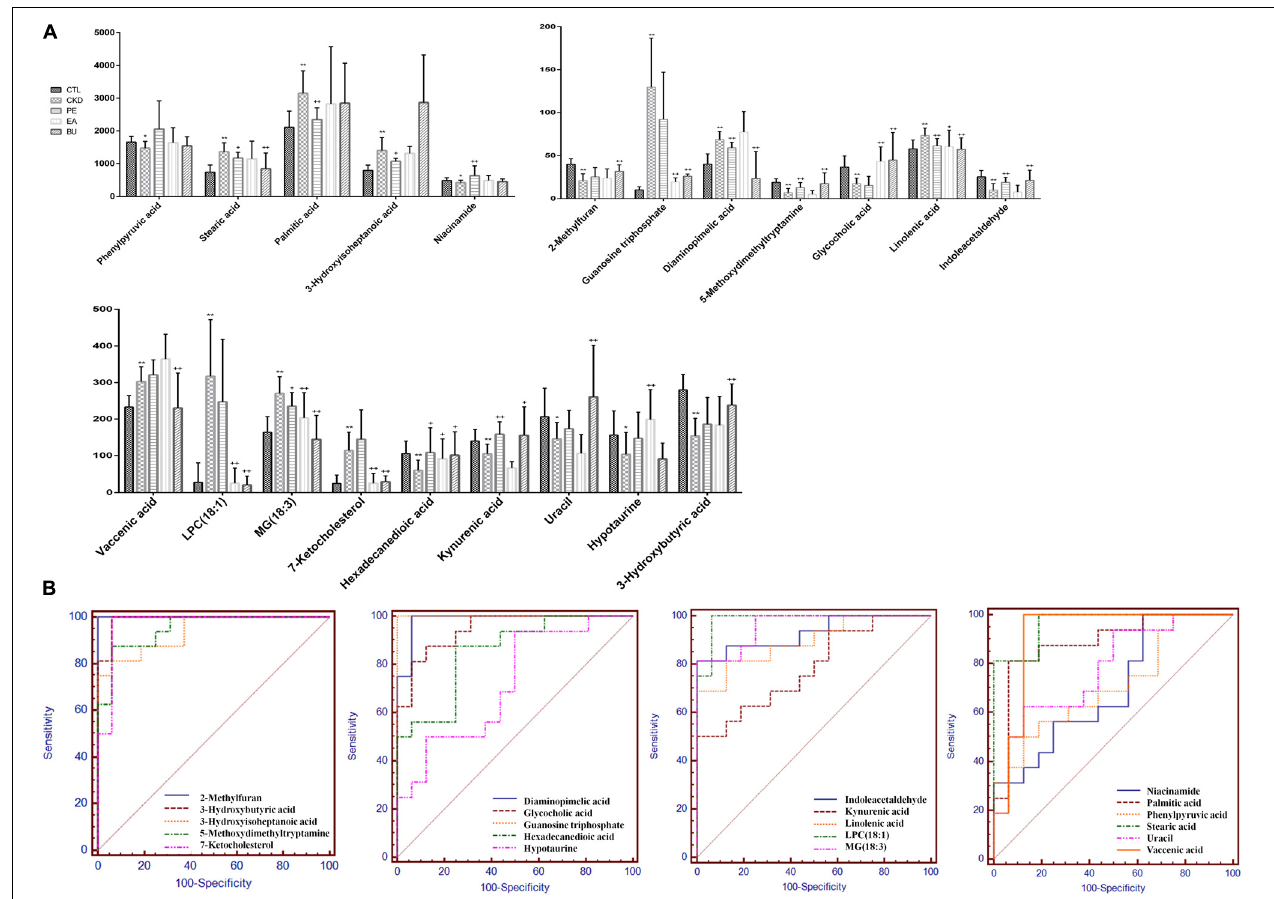
FIGURE 5 | Relative concentrations of the 21 metabolites in control, CKD, CKD+PE, CKD+EA, and CKD+BU groups (A) and their receiver operating characteristic curves (B) . ∗ p < 0.05, ∗∗ p < 0.01 compared to control group; + p < 0.05, ++ p < 0.01 compared to CKD